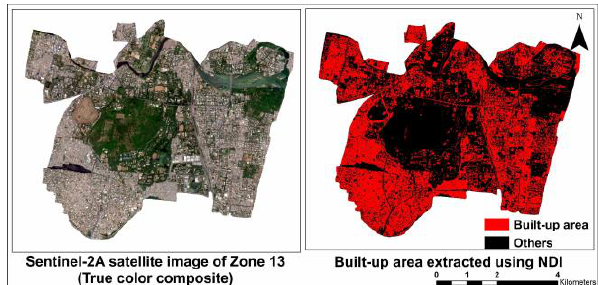
Figure 5 Sentinel-2A image of Zone 13 (left) and Built-up area extraction using NDI (right)